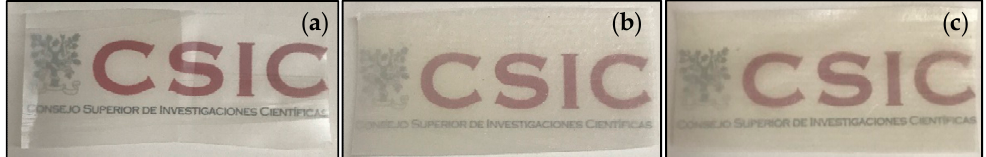
Figure 3. Visual aspect of: ( a ) YPACK210 film; ( b ) active multilayer films with cellulose nanocrystal (CNC) coating; ( c ) active multilayer films without CNC coating. Films are 5 cm × 2 cm. Table 1. Color parameters and transparency value of the neat YAPCK210 film and active multilayer films with and without cellulose nanocrystal (CNC)